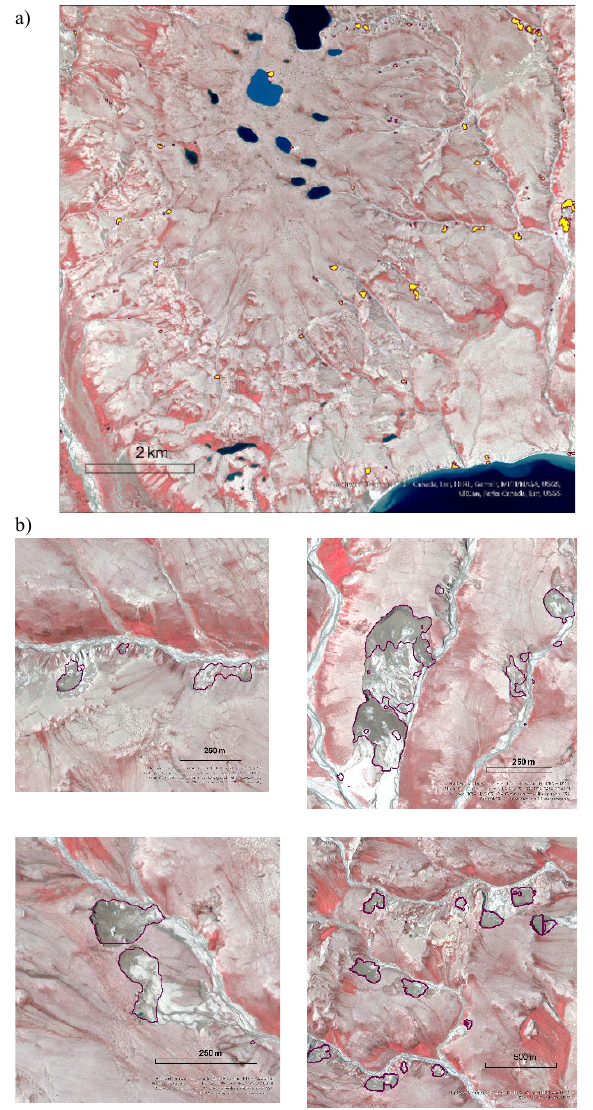
Figure 14 . (a) Model application in Banks Island. (b) Zoomed- in views of the detections. (Imagery © 2016 DigitalGlobe, Inc).